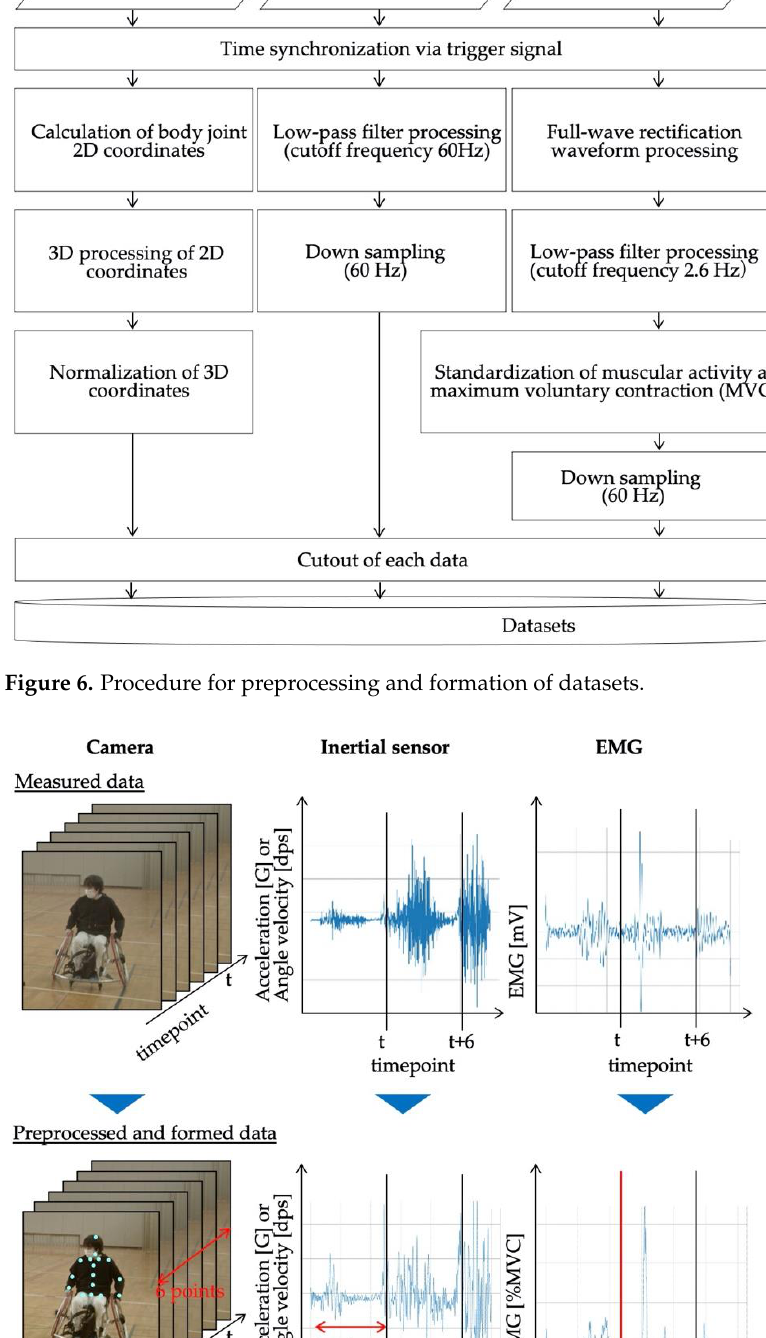
Figure 8. Body joints calculated from the camera image. 3.2. Neural Network Model Design A neural network model designed for myoelectric potential estimation is described in the following. Long Short-Term Memory (LSTM) [35] is generally used to extract fea- tures from time-series data. However, when attempting to recognize time-series data de- rived from muscle activity represented by an electrocardiogram, the one-dimensional